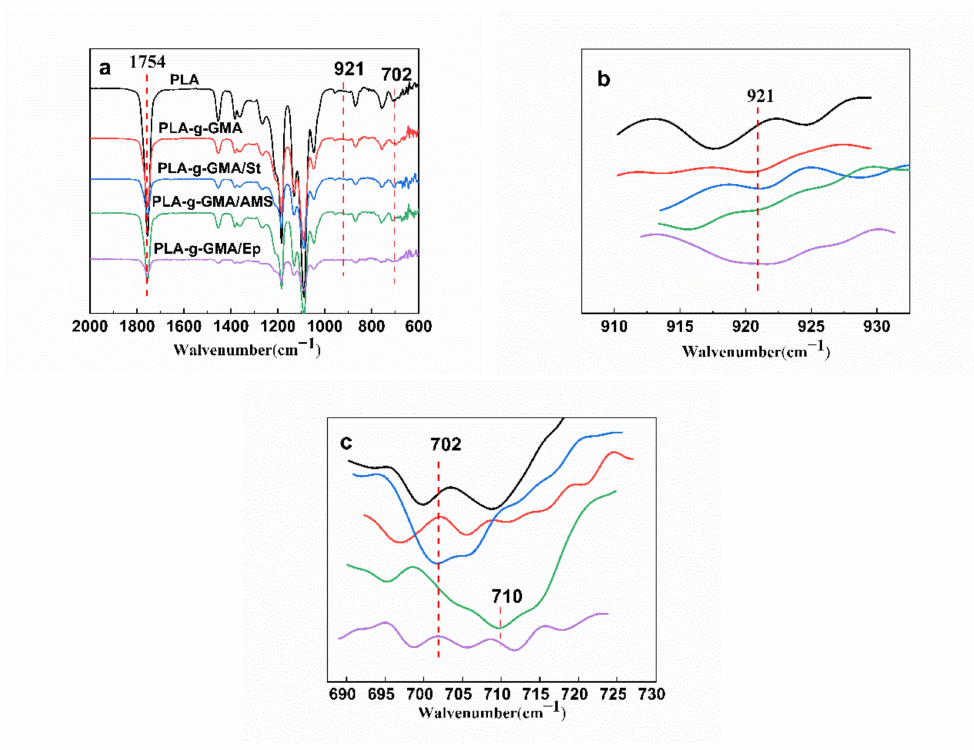
Figure 1. FTIR spectra of pure PLA and the PLA-g-GMA graft copolymers ( b , c ) are partial enlarged views of the red-dashed areas in ( a